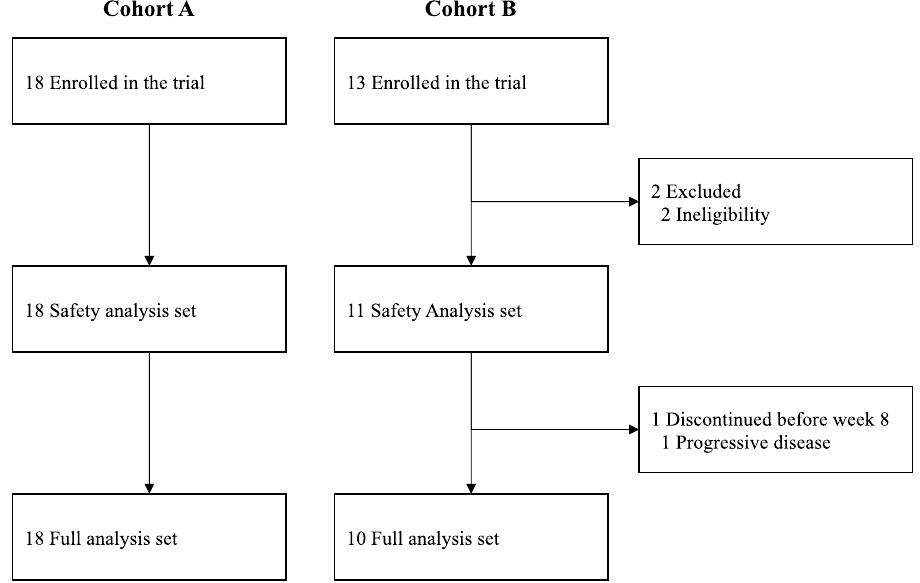
Figure 1. Consolidated standards of reporting trials (CONSORT) flow diagram.